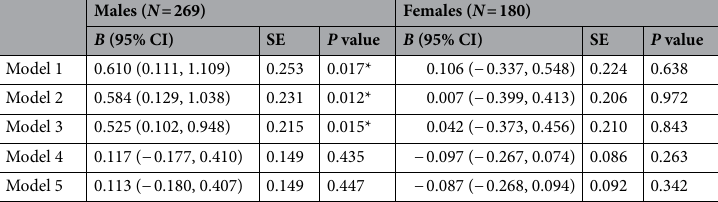
Table 2. Other independent predictors of pericardial fat in men included waist to hip ratio, HDL cholesterol, HOMA-IR and IL-6. In women, there was no statistically significant association between depressive symptoms and pericardial fat at baseline in any of the models. IL-6 was also not associated with pericardial fat at baseline ( B = 9.515, 95% CI − 14.340–33.371, p = 0.432). The only independent predictors of pericardial fat in women were age and waist to hip ratio. The longitudinal associations between depressive symptoms and pericardial fat are presented in Table 3. In men, depressive symptoms were associated with pericardial fat three years later, after adjustment for age and employment grade ( B = 0.610, 95% CI 0.111–1.109, p = 0.017, Model 1). This association remained statistically significant after further adjustment for waist to hip ratio ( B = 0.584, 95% CI 0.129–1.038, p = 0.012, Model 2). Additional adjustment for smoking, LDL cholesterol, HDL cholesterol, triglycerides, systolic blood pressure and HOMA-IR had little effect on the association ( B = 0.525, 95% CI 0.102–0.948, p = 0.015, Model 3). However, after adjustment for baseline levels of pericardial fat, the association between depressive symptoms and pericardial fat